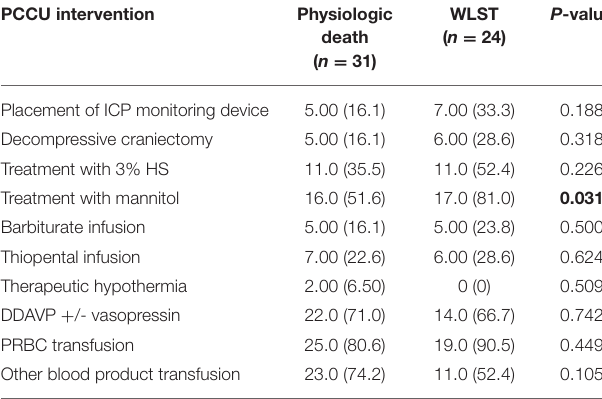
TABLE 2 | PCCU interventions for the management of sTBI by mode of